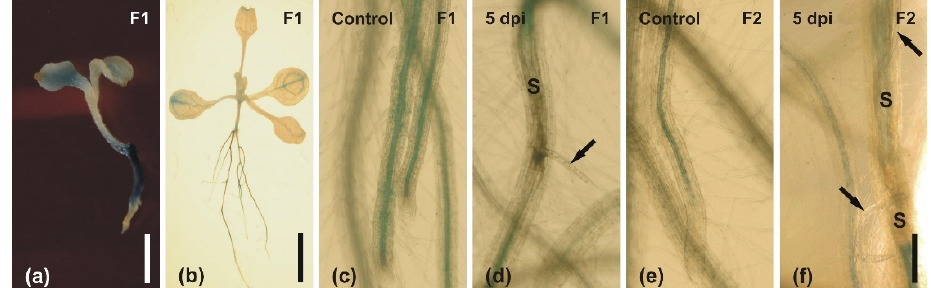
transgenic A. thaliana plants: ( a – c , e ) control non-inoculated plants; ( d , f ) infected roots with juveniles and syncytia at 5 dpi; ( a – d ) GUS activity driven by the F1 (704 bp) fragment of the AtMYB59 promoter; ( e , f ) GUS activity driven by the F2 (507 bp) fragment of the AtMYB59 promoter; ( a ), three-day-old seedling (slight GUS activity present in cotyledons and strong in roots); ( b ), seven-day-old seedling (GUS activity present in roots and vascular tissues of cotyledons); ( c ) GUS activity under control of the F1 promoter fragment in non-inoculated roots; ( d ) GUS activity under control of the F1 promoter fragment in 5 dpi roots; ( e ) GUS activity under the control of the F2 promoter fragment in non-inoculated roots; ( f ) GUS activity under the control of the F2 promoter fragment in 5 dpi roots. GUS activity was evidenced in the vascular tissues of non-inoculated roots, but it disappeared in nematode feeding sites. Abbreviation: S, syncytium. Arrows indicated juveniles of the nematode. Scale bars: